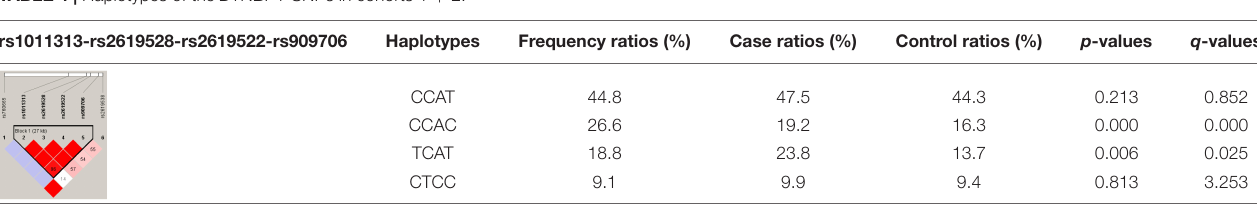
TABLE 4 | Haplotypes of the DTNBP1 SNPs in cohorts 1 +